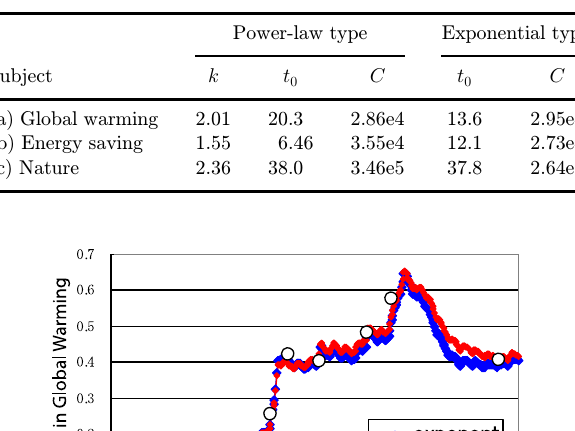
Table 2. Values of parameters for the two types of oblivion function.